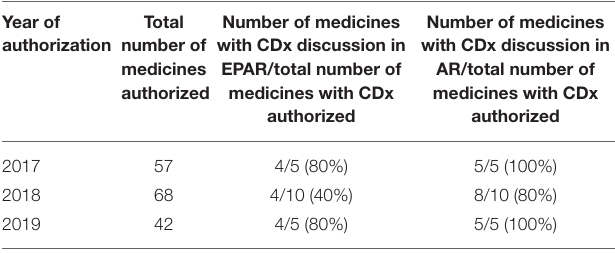
TABLE 2 | The assessment of CDx in registered medicines at the EMA in